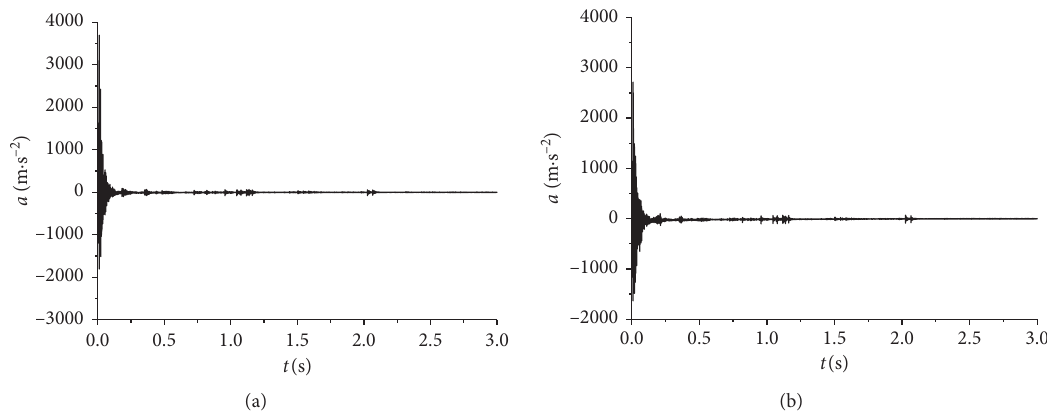
Figure 6: Measured acceleration time-history curves of spring-aluminum foam isolation device. (a) TPMLG1. (b)